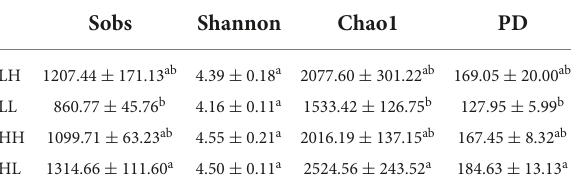
Different lowercase letters indicate significant differences ( p < 0.05) among the differentsamplingareas.